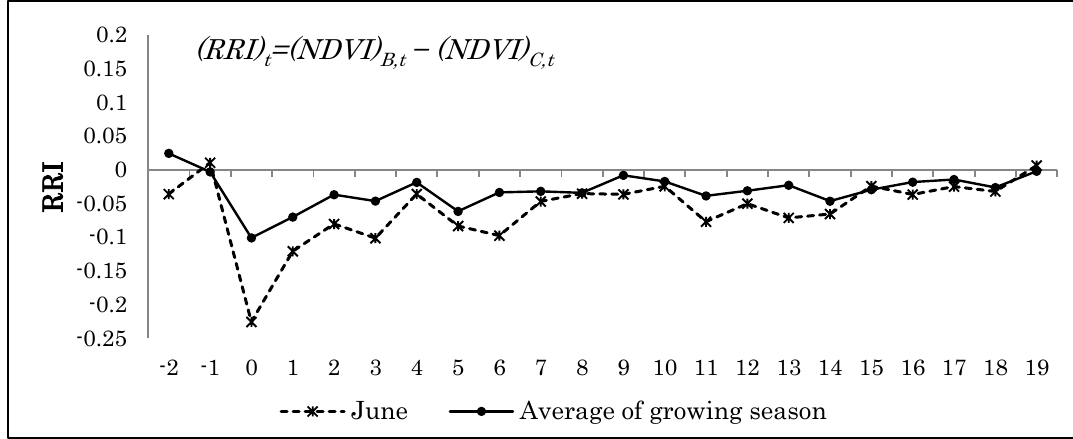
Figure 7. The evolution of RRI calculated using NDVI difference between fire scars and the unburned control area for the growing season average (April to October) and June (the month immediately after the fire in 1987) time series. Zero on the time scale represents the burn year, i.e. , relative year 0 is the year of the wildfire event. Relative year −1 and +1 corresponds to the year before and after the fire event,